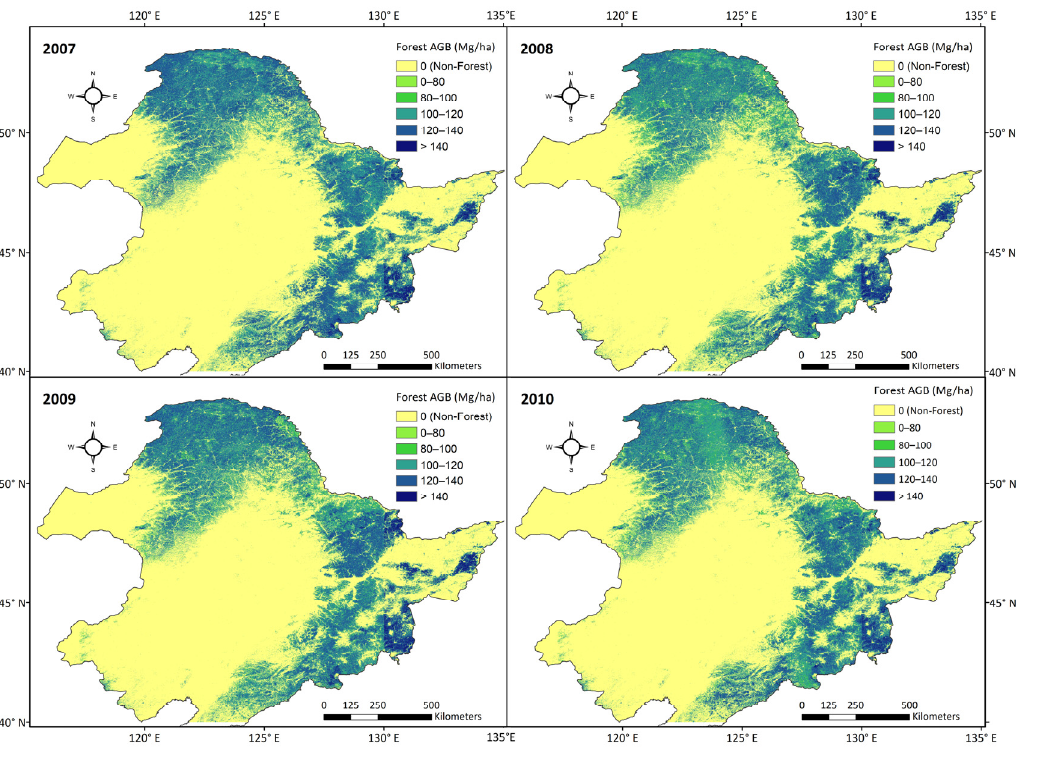
Figure 10. Forest AGB maps for 2007–2010 at 90 m spatial resolution generated using SCHE selected features and the XGBoost algorithm.